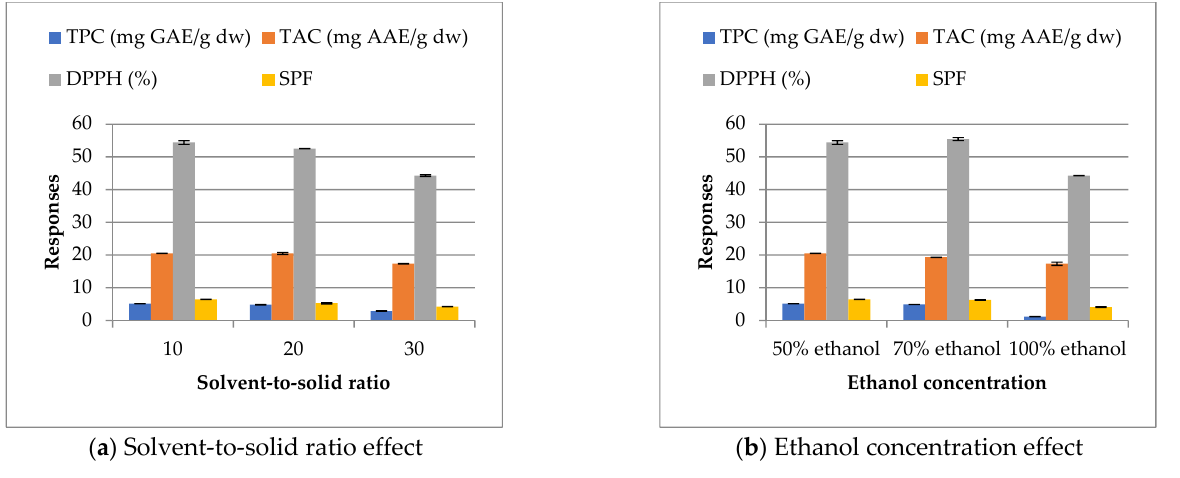
Figure 1. Effect of solvent-to-solid ratio and ethanol concentration on responses (maceration at 25 °C for 60 min).